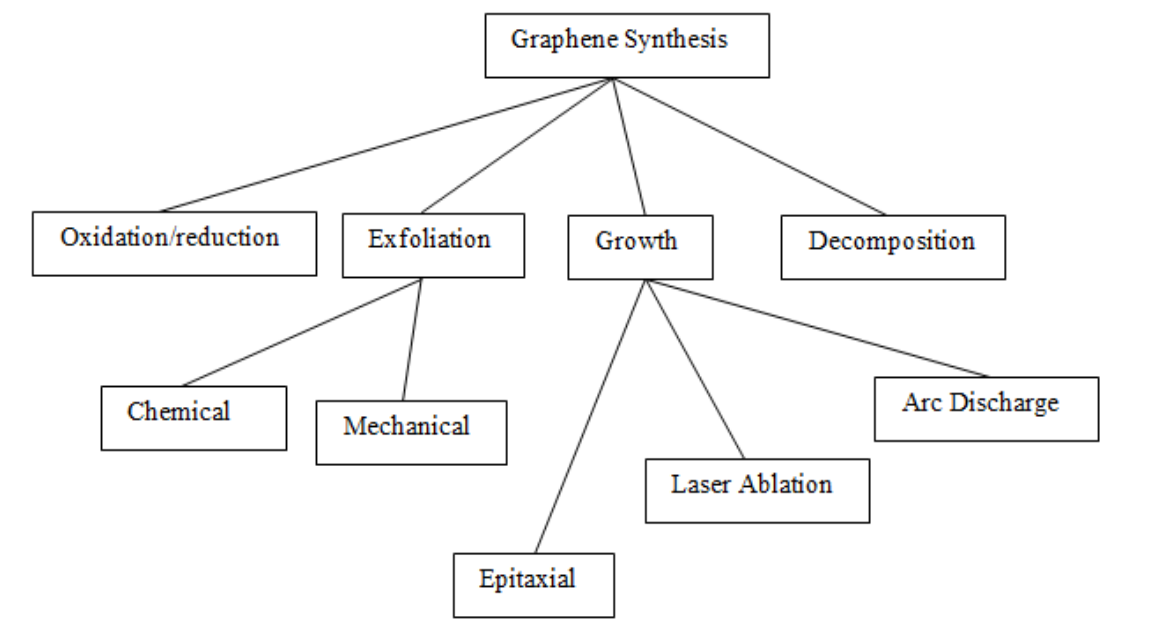
Figure 1. Methods for the synthesis of graphene.